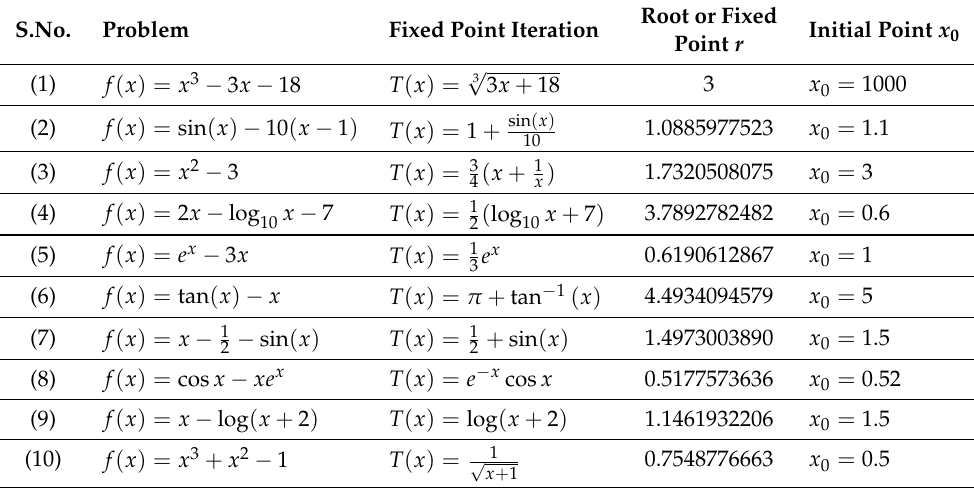
Table 1. Test problems for one-step